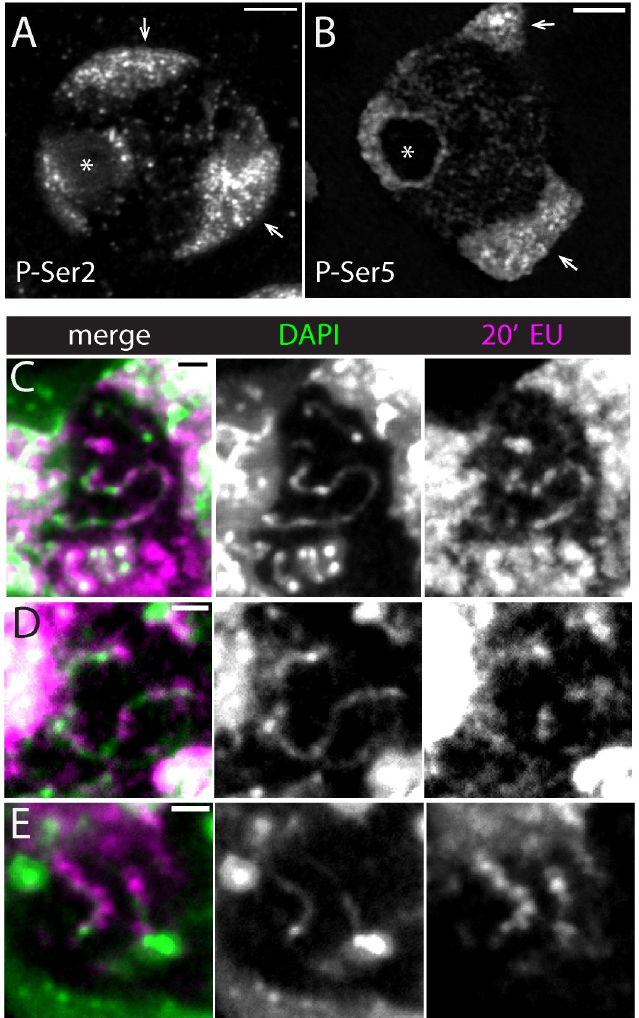
Fig 10. Polymerase and nascent transcription: confocal overview. (A and B) Immunofluorescence images of RPol- PSer2 and RPol-PSer5 respectively in primary spermatocytes of larval testis whole-mounts. Single central confocal slices are shown. Arrows indicate autosome masses, asterisk indicates nucleolus, scale bars are 3 μ m. (C-E) show nascent RNA along DNA fibres. Nascent RNA labelled by 20min incubation with EU (magenta) gives a blobby appearance along DAPI stained Y loops (green). (C) Maximum intensity projection of five confocal slices with a 150nm step size captures a long Y loop section through the nucleoplasm. (D) and (E) are single slices. Scale bars are 1 μ